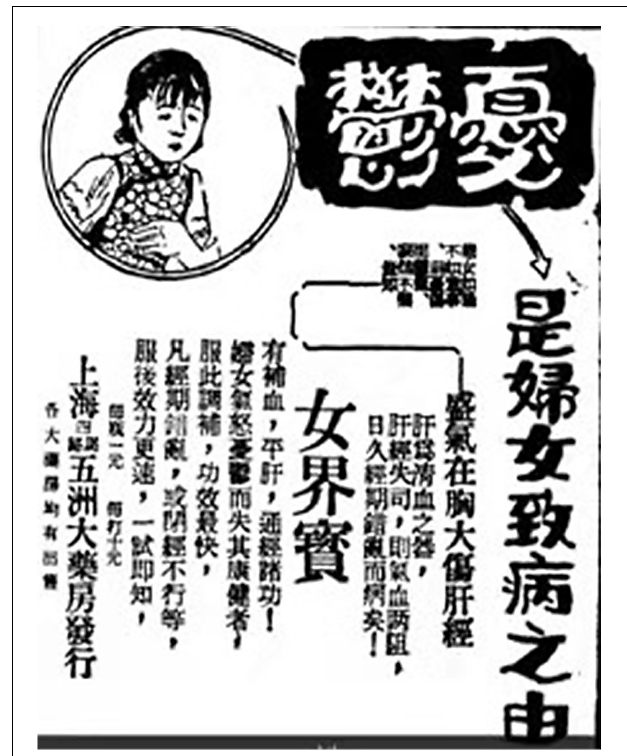
FIGURE 2 | Advertisement of Treasure of the Women’s World . Source: The News ( ), 13 April